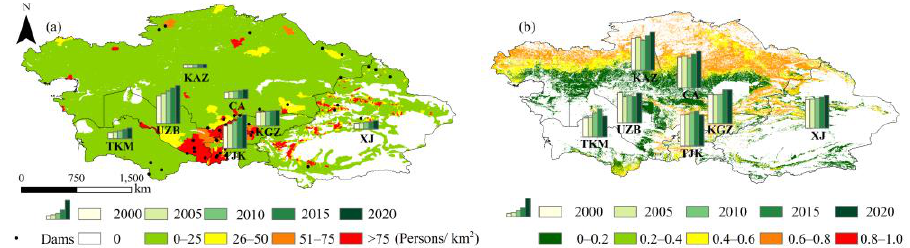
Figure 9. Impact of human activities (( a ). population density and dams and reservoirs in CA; ( b ). the utilization intensity index of the main grazing grasslands in CA).